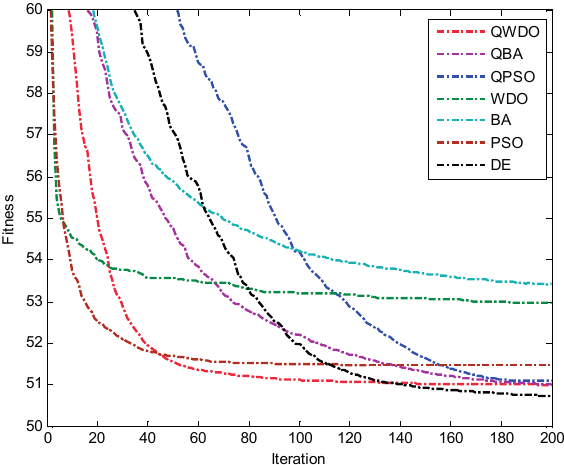
Figure 11. Fitness of the first instance for D = 20.